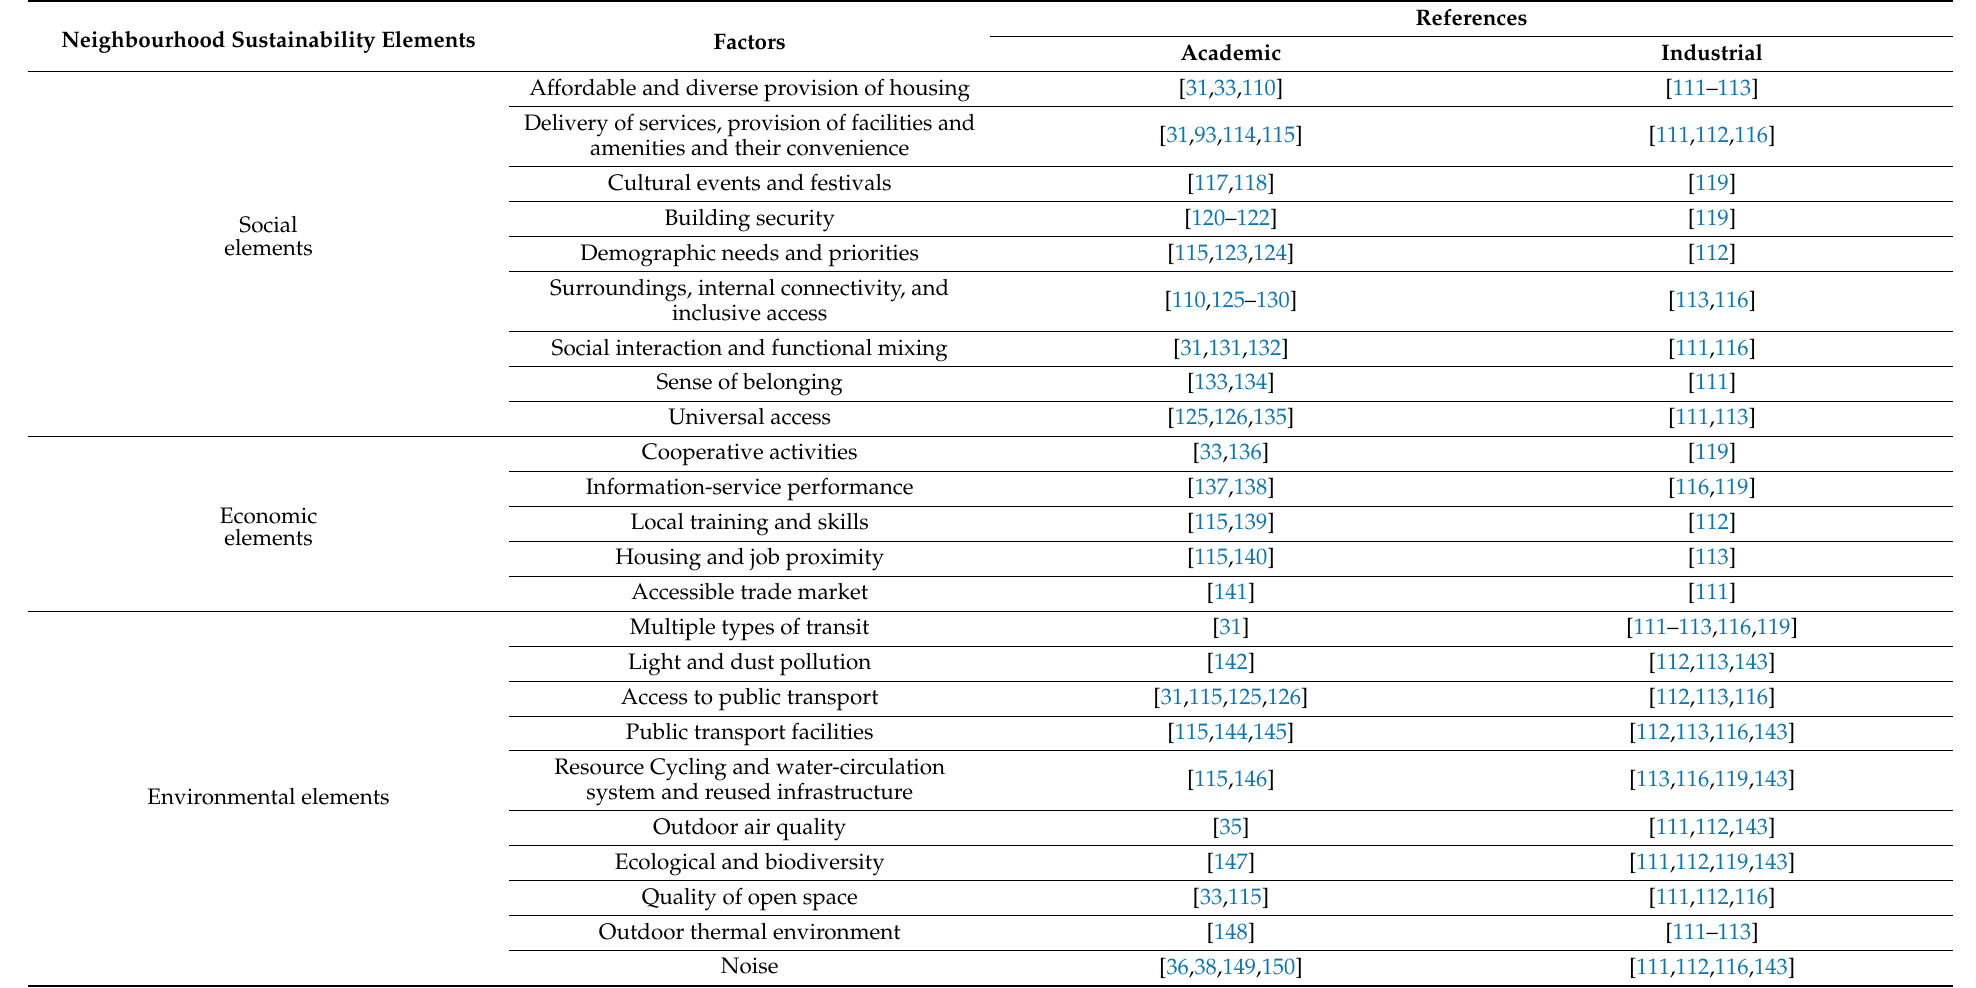
Table A1. Theoretical framework of neighbourhood sustainability factors adopted in this